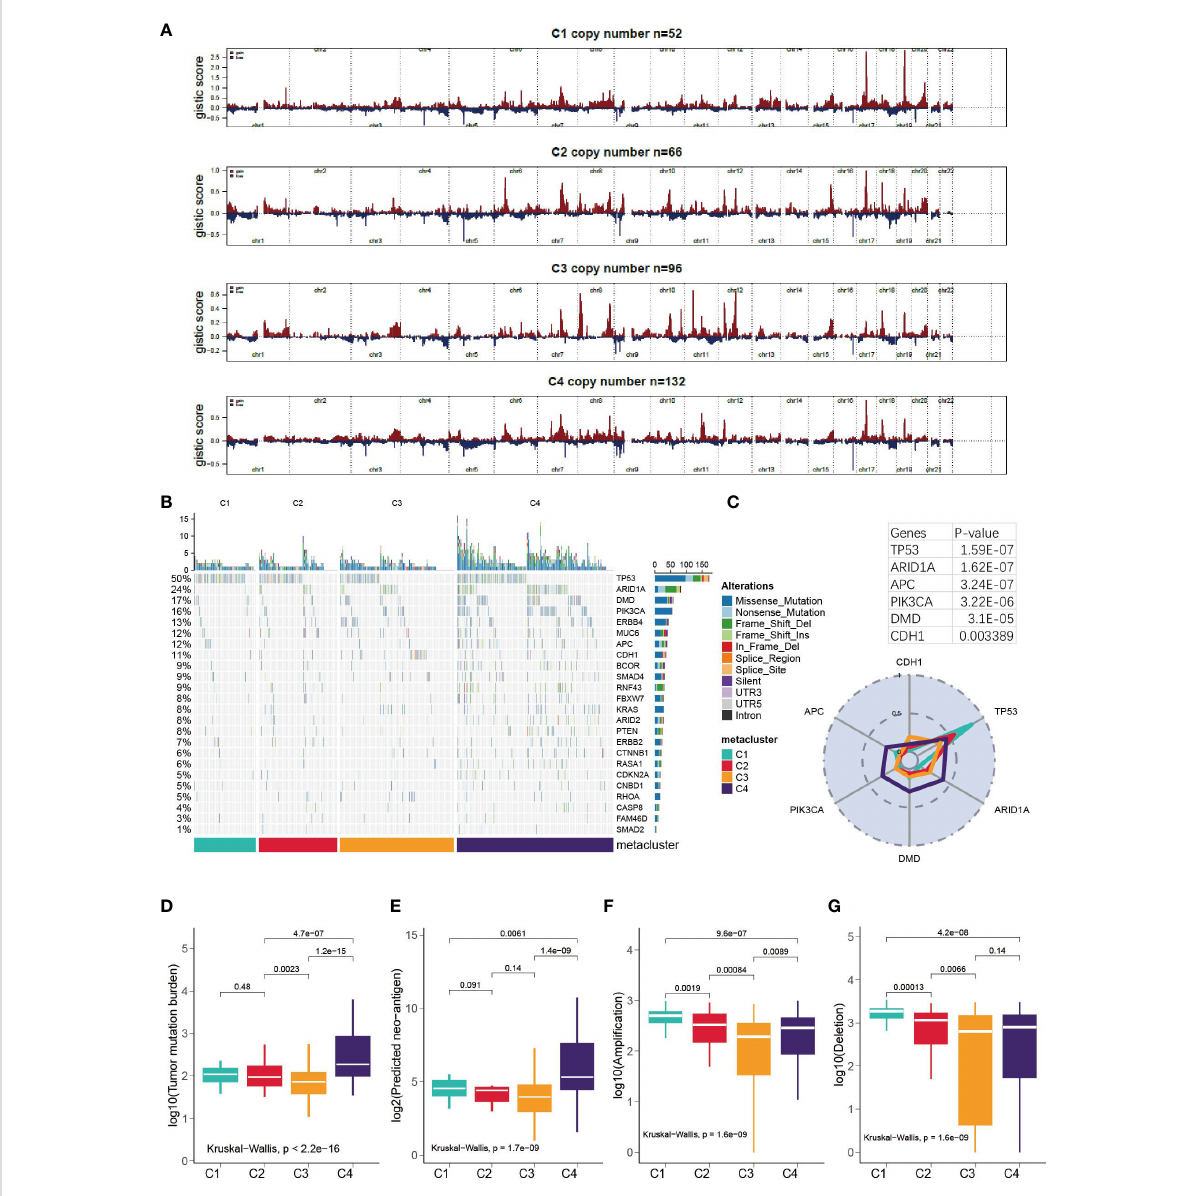
FIGURE 5 Correlation of GC subtypes with copy number variation, somatic mutation, tumor mutation burden and neo-antigen. (A) Visualization of the copy number variation, GISTIC plot for C1-C4. (B) oncoPrint for C1- C4. (C) Mutation rate of top mutated cancer driver gene in each subtype. (D-G) Correlation between subclasses and TMB, neoantigen, deletion and ampli fi